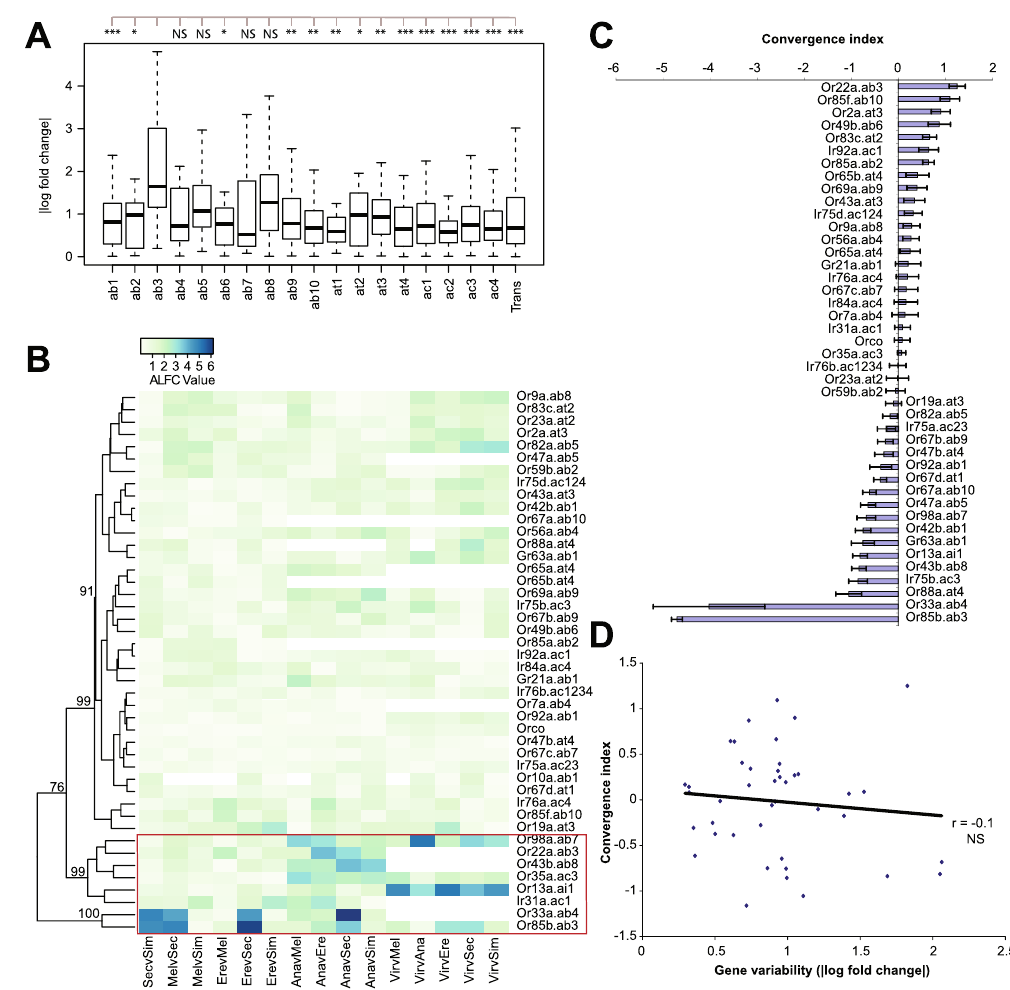
Figure 4. Transcriptional variability of olfactory receptors across six Drosophila species. (A) Boxplot and ( B ) heatmap plotting the absolute log fold change (ALFC) in the expression of olfactory receptors (ORs) across all pairwise interspecies comparisons. The boxplot shows combined values for each sensilla subtype, and includes values for the entire antennal transcriptome (Trans) for comparison. Statistical comparisons show results for ANOVA + Tukey’s HSD ( * p < 0.05, ** p < 0.01, *** p < 0.001, NS = not significant). The post-hoc test compares ab3 AFLC to the other classes of ORs. A non-parametric Kruskal-Wallis H test for the boxplot also had p-value < 0.001 (df = 5). In the heatmap, invalid comparisons without comparable orthologs (NAs) are white/ blank, highly variable genes are highlighted in red, and numbers indicate bootstrap support for the clustering analysis. (C) Convergence index values (see Methods) showing levels of convergence between D . sec . and D . ere . for olfactory receptor genes in the antenna. Positive values indicate convergence while negative values indicate divergence. Error bars indicate S.E.M. (D) Plot of convergence index values versus absolute log fold change (ALFC) values for antennal olfactory receptor genes. ALFC values shown are the mean ALFC value across all interspecies pairwise comparisons. The solid line shows a fitted line, with r as Pearson’s correlation